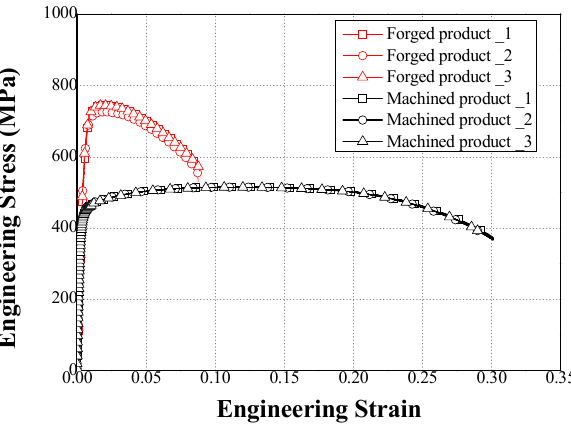
Figure 8. Comparison of the tensile test results for the forged and machined products.